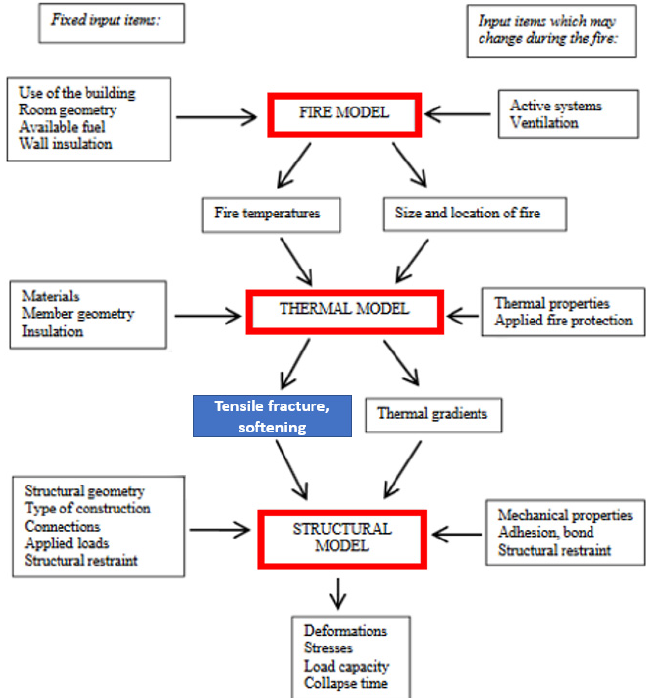
Figure 5. Procedural steps for thermo-mechanical numerical analysis of load-bearing components and structures under fi re conditions (reproduced from [61] under the terms and permission of a CC-BY copyright license agreement).